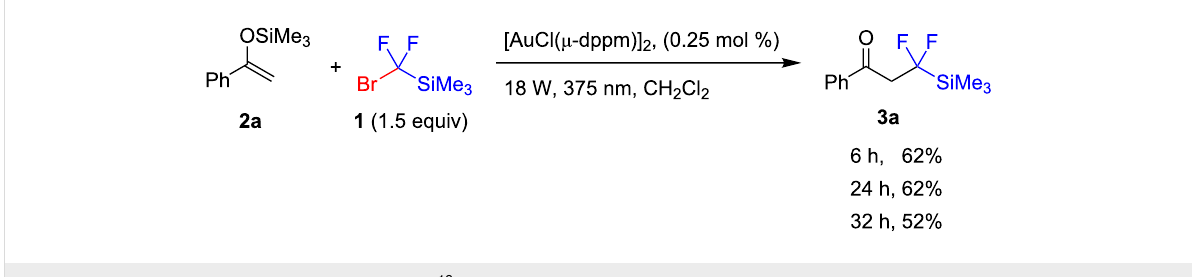
Scheme 2: Optimization studies. Yield determined by 19 F NMR spectroscopy using an internal standard.